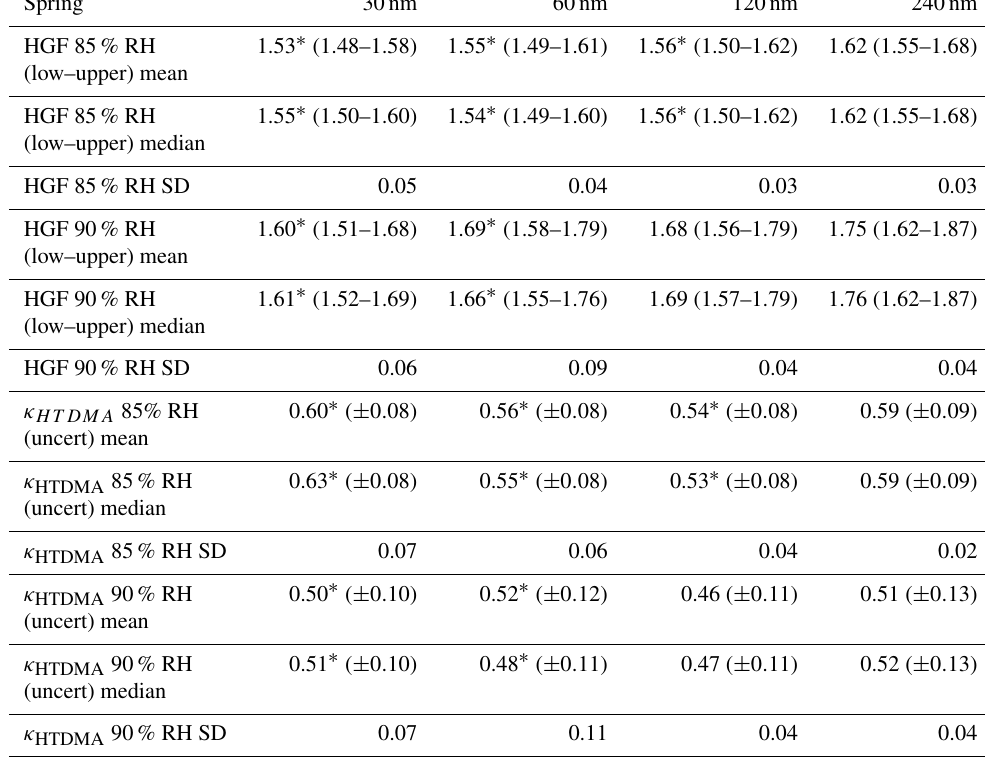
Table 4. Statistics of HTDMA measurements during the spring study. The stated uncertainties are the respective statistics of the associated uncertainty retrieved from the fitting procedure as described in Sect. 2.5. The values of SD are the standard deviations of the parameter distributions over the temporal evolution of the studies. The asterisk ( ∗ ) signifies a significant difference between spring and summer field studies (Wilcoxon rank sum test, p < 0 . 05). HTDMA measurements for the spring field study were obtained from 22 April to 2 May. Spring 30nm